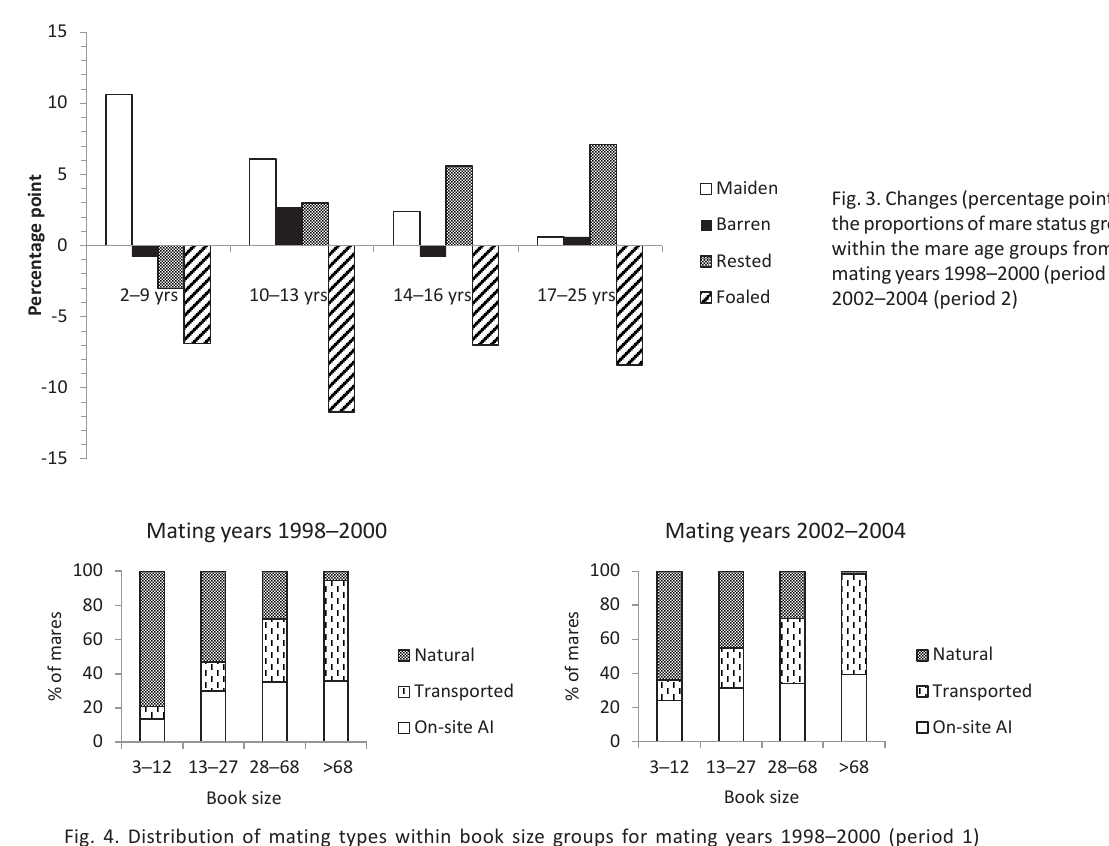
Fig. 3. Changes (percentage points) in the proportions of mare status groups within the mare age groups from the mating years 1998–2000 (period 1) to 2002–2004 (period 2)